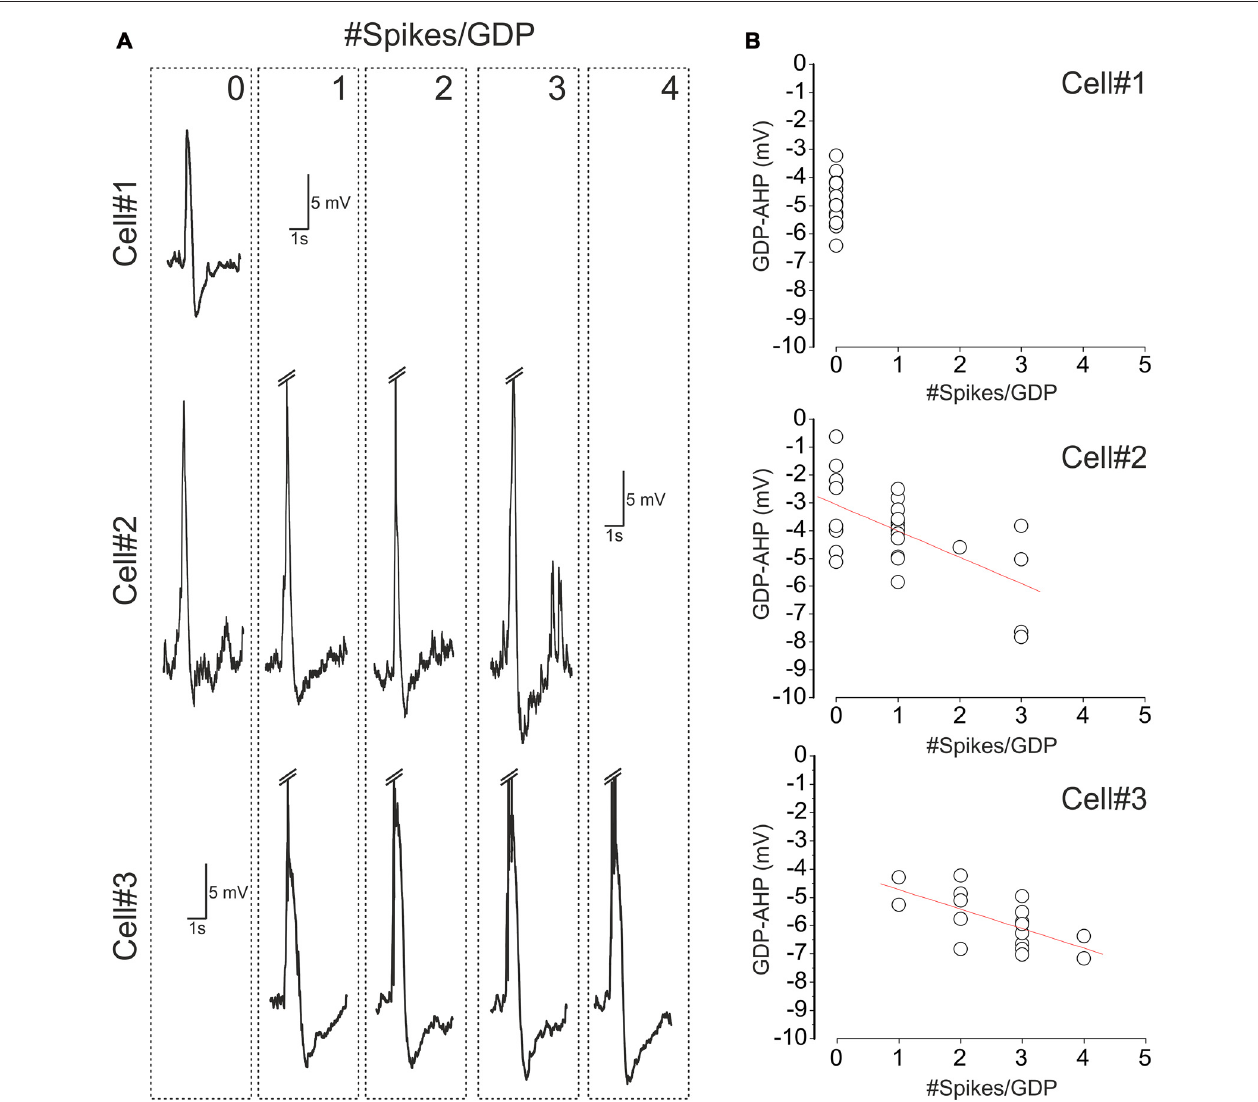
FIGURE 2 | Variability of cell firing and GDP-AHP in CA3 pyramidal cells. (A) Examples of GDPs in three CA3 pyramidal cells sorted by the number of spikes that each cell fired during GDPs (the number of spikes per GDP is indicated at the top right corner of the dashed boxes). Spikes are truncated. Note that cell#1 never fired during GDPs, cell#2 fired from 0 to 3 spikes and cell#3 fired from 1 to 4 spikes per GDP. (B) Corresponding plots of the amplitude of GDP-AHP as a function of the number of spikes during GDP. Each circle corresponds to an individual GDP. Note that GDP-AHP is present after GDPs without spikes and that the size of GDP-AHP increases with the number of spikes during